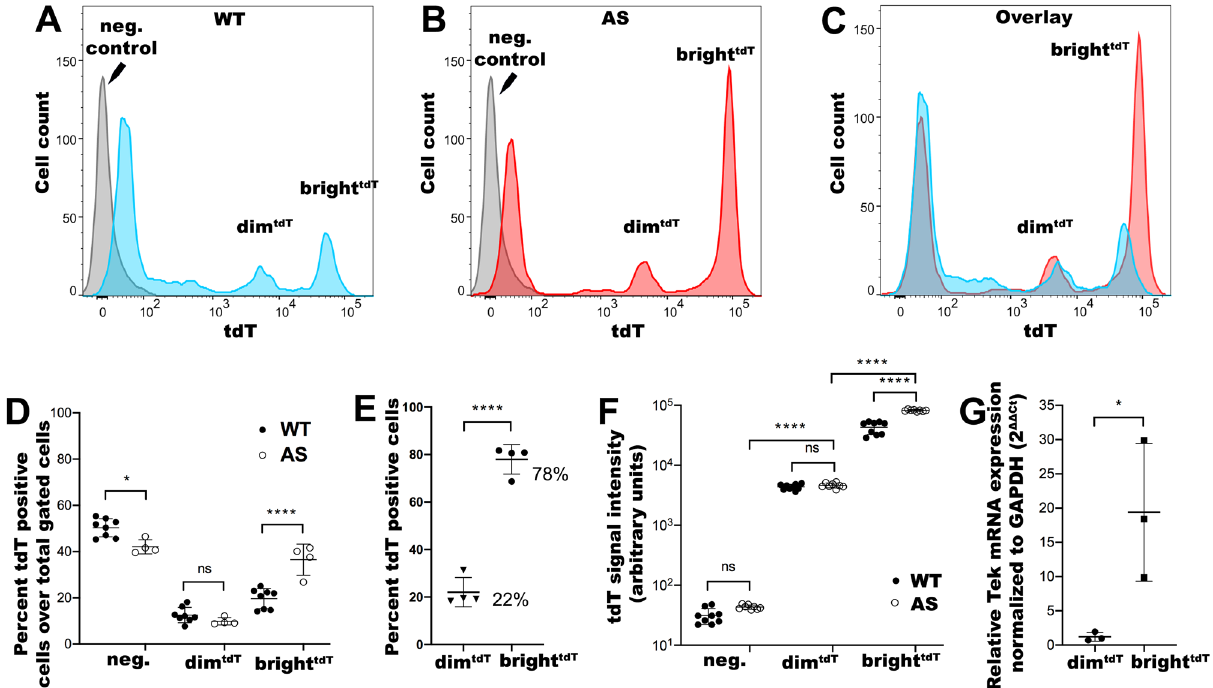
Figure 3. Tek-tdT expression patterns in WT and Alport glomeruli. ( A–C ) Representative histograms showing the distribution of the tdT-signal in WT ( A ) and Alport glomeruli ( B ) as measured by DB FACSCanto II and analyzed by FlowJo v10 analysis software, and their comparison ( C ). ( D ) Dot plots showing the percent distribution of the tdT-positive and -negative cell populations over total gated cells in AS glomeruli (biological replicates, n = 4 mice) in comparison to their WT counterparts (biological replicates, n = 8 mice; see gating strategies in supplementary Fig. 7). € ( E ). Dot plots showing relative percent compositions of dim tdT (22%) and bright tdT (78%) GEC subpopulations in the AS glomeruli as determined based on the total number of gated tdT positive cells (see gating strategies in supplementary Fig. 6). ( F ) Dot plots showing the tdT-signal intensities (measured in arbitrary units) for GEC subpopulations in AS (biological replicates, n = 8) and WT glomeruli (biological replicates, n = 9). ( G ) Dot plots showing RT-qPCR analysis of Tek expression from AS dim tdT and bright tdT GEC normalized to GAPDH according to the 2∆∆ Ct method; (biological replicates, n = 3 mice/ group). The data are presented as mean ± SD. * denotes p value < 0.05; ** denotes p value < 0.01; *** denotes p value < 0.001; **** denotes p value < Fig. 5A). When compared to WT, the AS-dim tdT and not the bright tdT cells showed significant downregulation of Sdc2, Gpc4 and Gpc6 (Fig. 8A), which might suggest new, previously unknown mechanisms of CKD progres- sion in AS. Integrins, ECM and endothelial specific gene expression in WT and AS GEC.